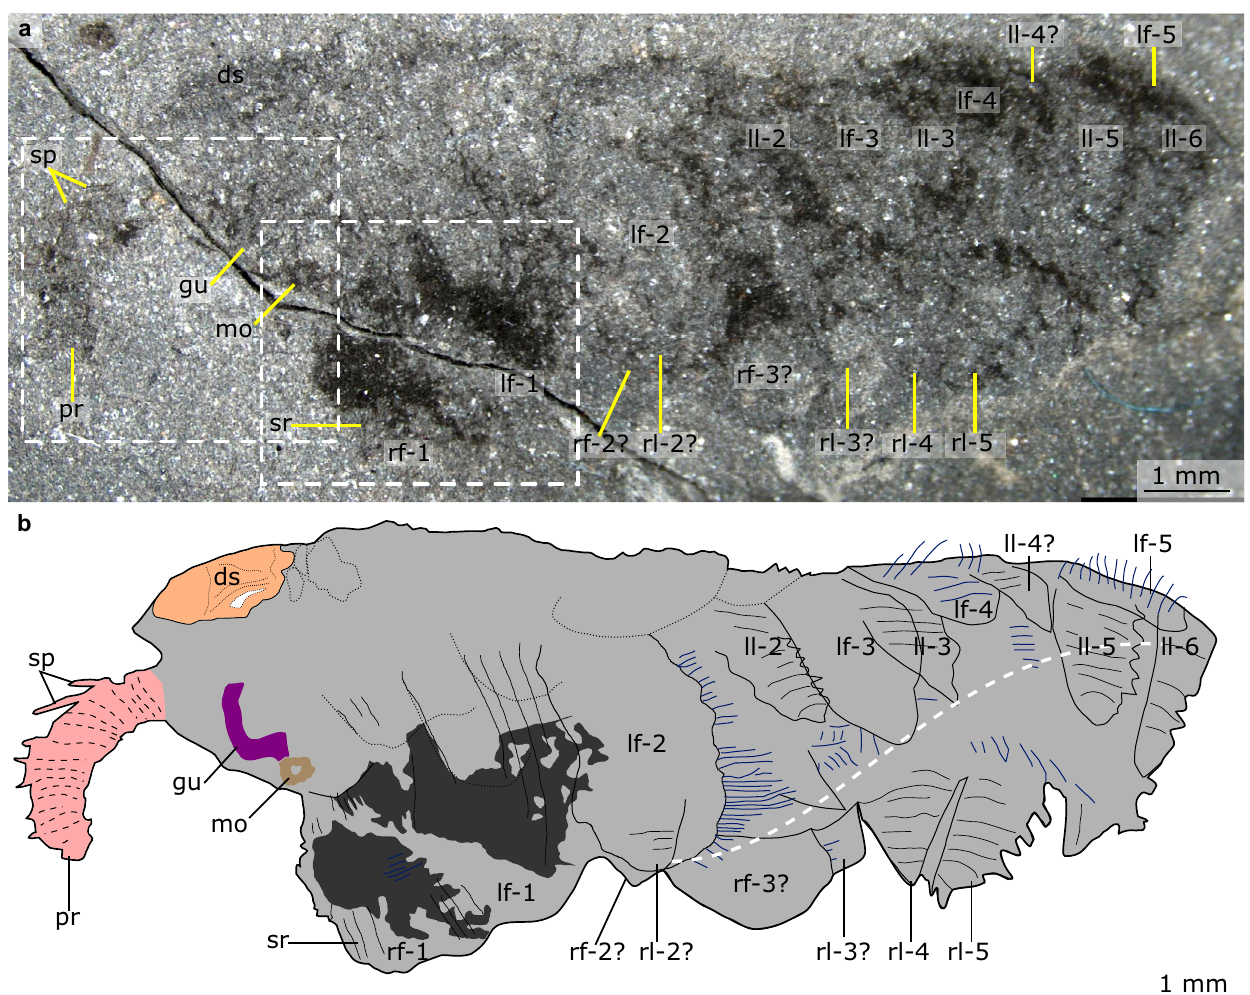
Fig. 1 | Mieridduryn bonniae nov. gen. et sp. from the Castle Bank Biota (NMW.2021.3G.7). a Overview of whole specimen. Boxes indicate areas depicted in Fig. 2. b Explanatory drawing of ( a ). Dashed white line indicates ventralmost point of left dorsolateral fl aps, and demonstrates the twisted nature of the